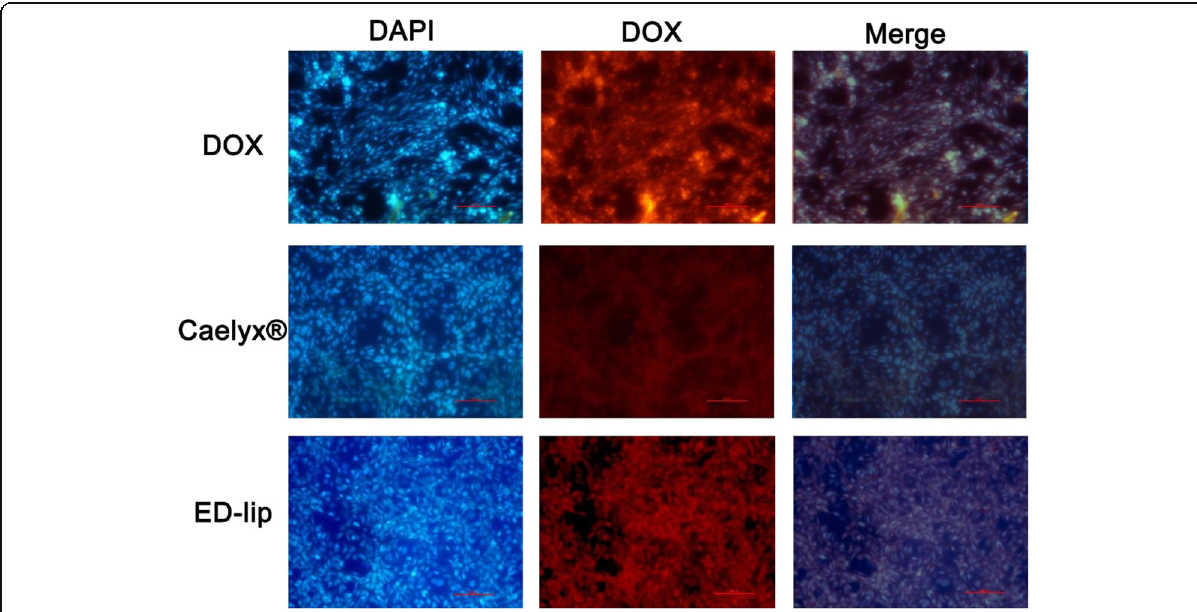
Fig. 5 Fluorescent microscopy. The results of cell internalization of DOX on C26 cell lines visualized by fluorescent microscopy. Cells stained with DAPI. Both free DOX and ED-lip have higher level of DOX internalization compared to the Caelyx®. Cells inspected under × 200 magnification